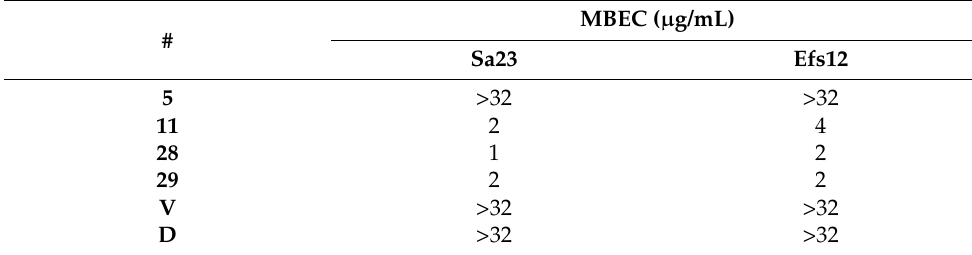
Table 3. Biofilm studies of potent